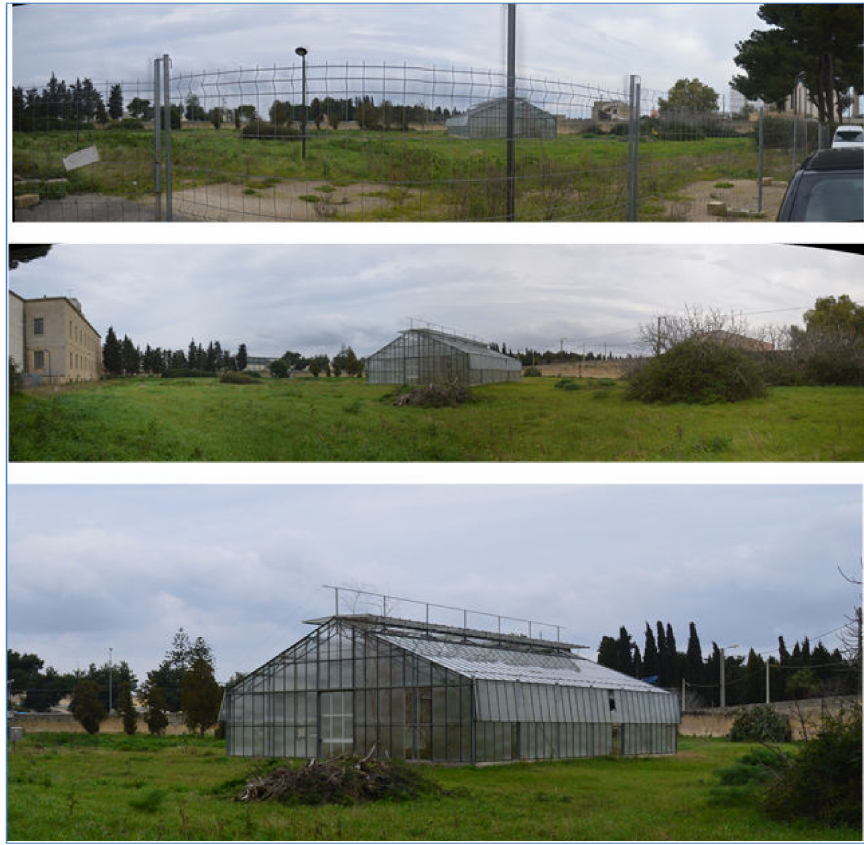
Figure 11. Photos of the